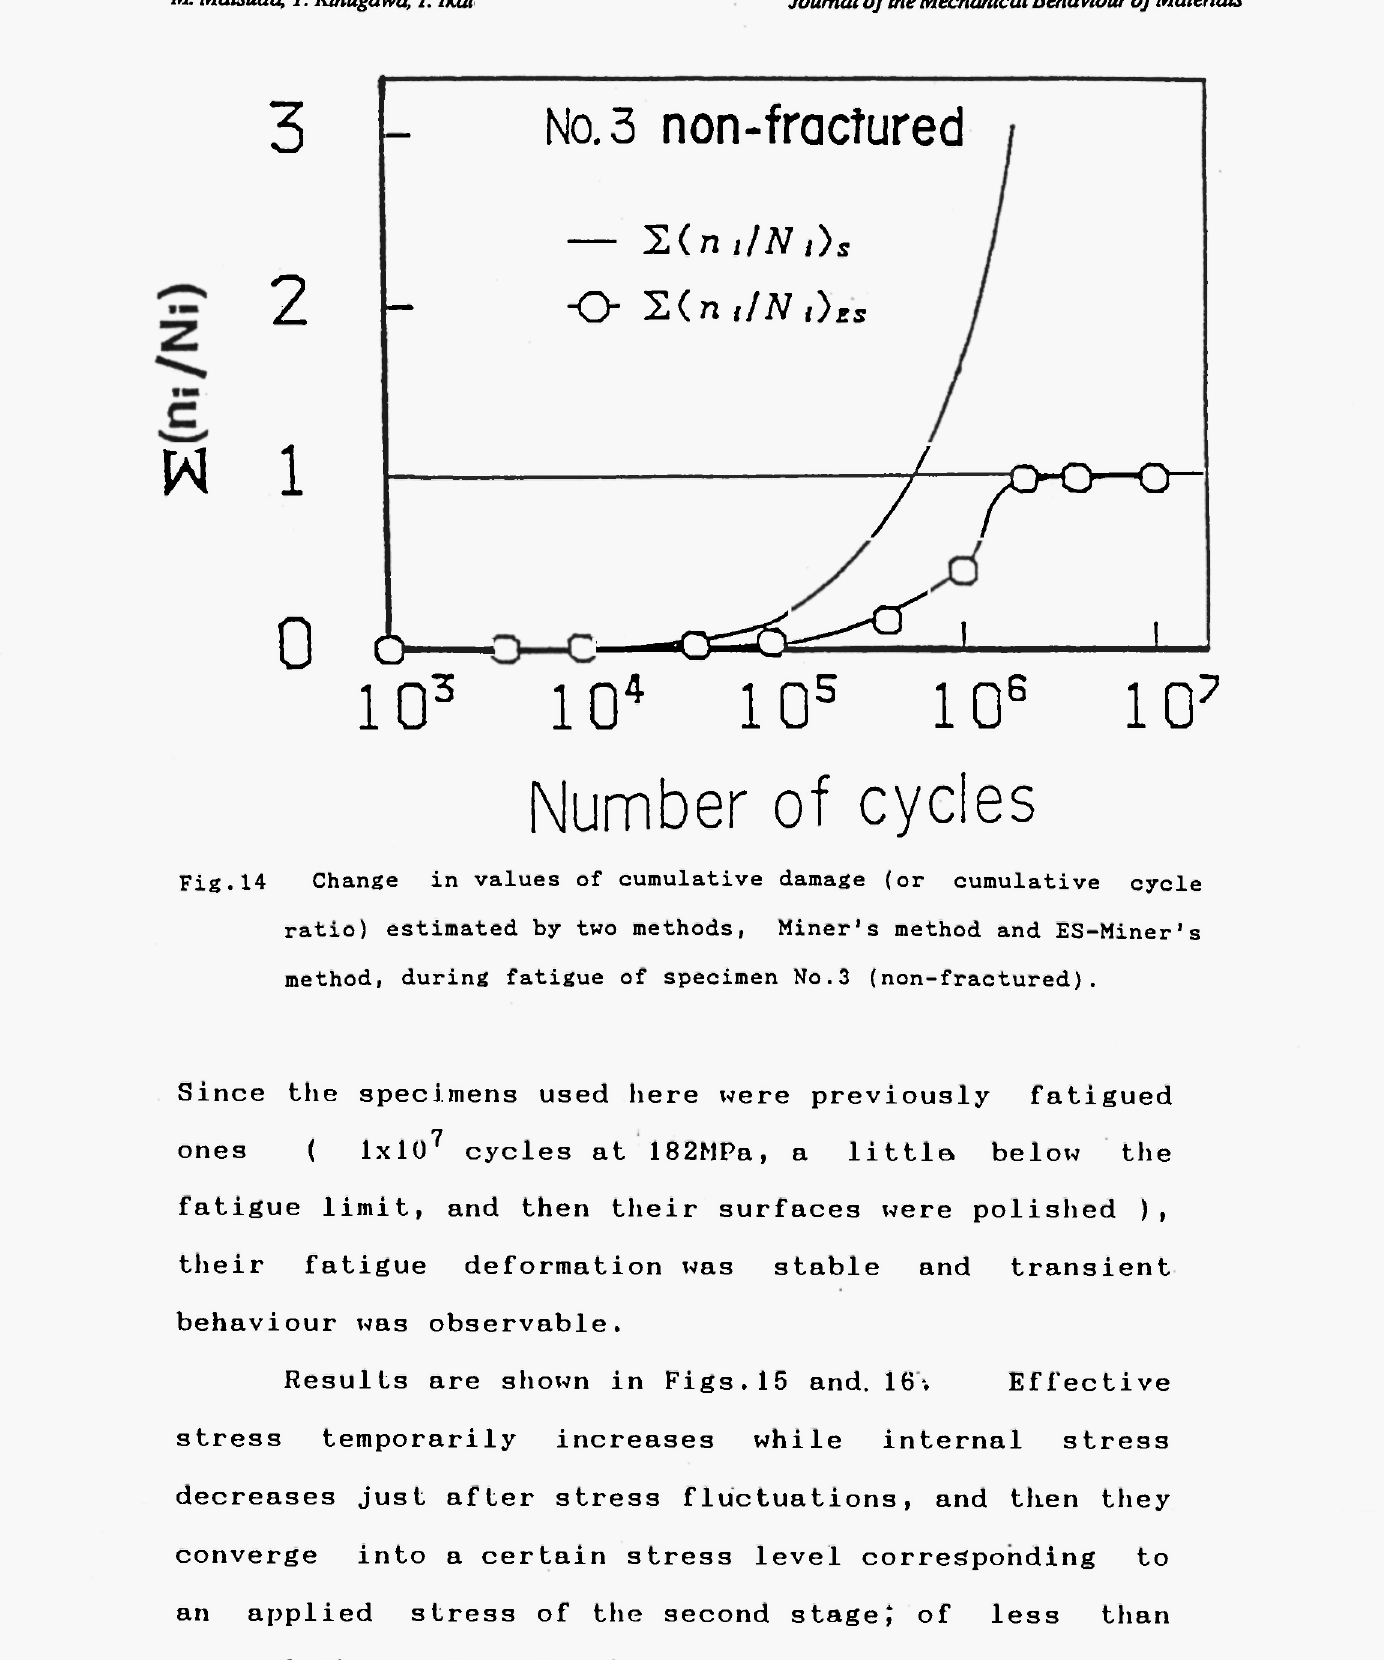
Fig.14 Change in values of cumulative damage (or cumulative cycle ratio) estimated by two methods, Miner's method and ES-Miner's method, during fatigue of specimen No.3